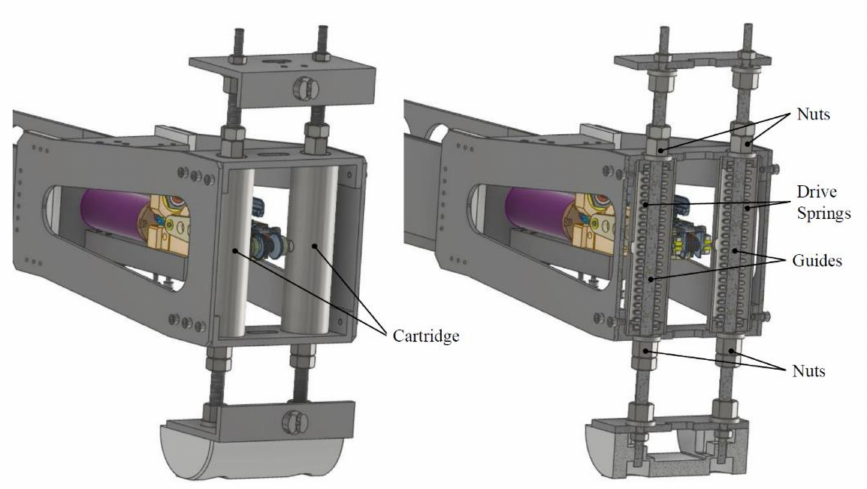
Figure 5. (Left ) representation of the BB-0B. ( Right ) cross-section through guides to show the realization of the concept in